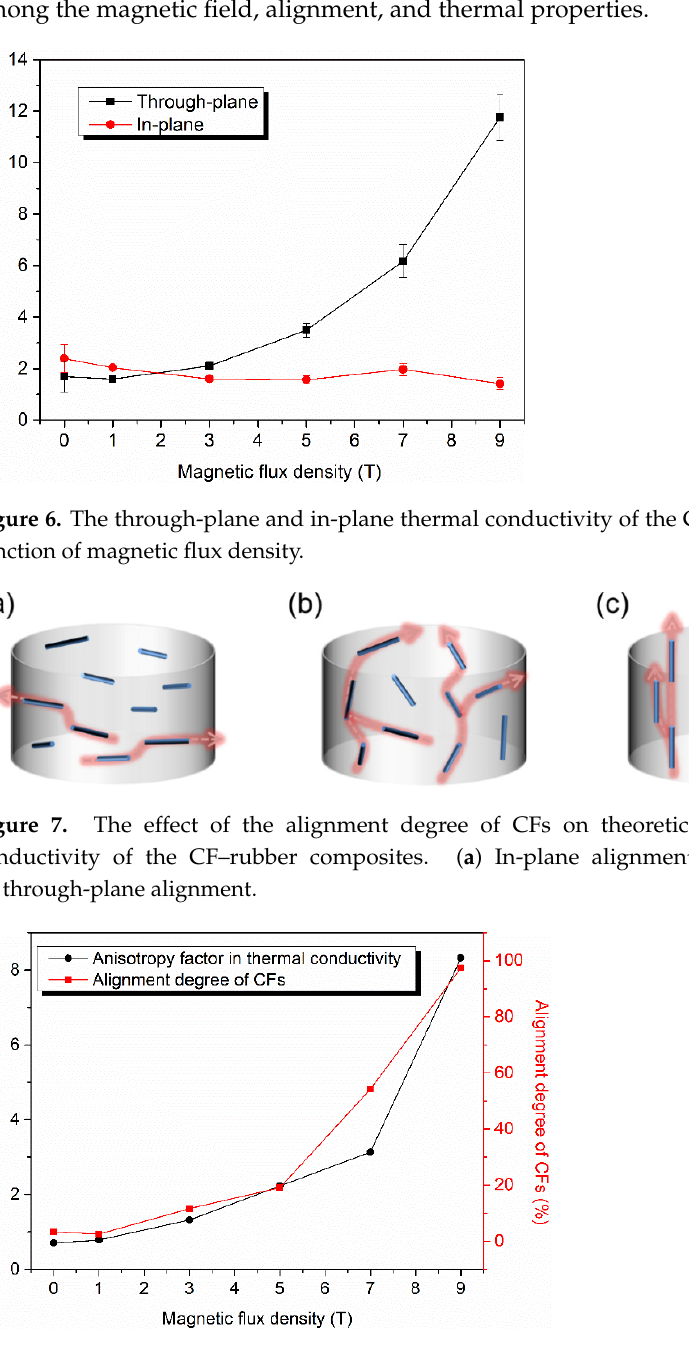
Figure 8. The anisotropy factor in the thermal conductivity of the CF–rubber composites and the corresponding alignment degree of the CFs.